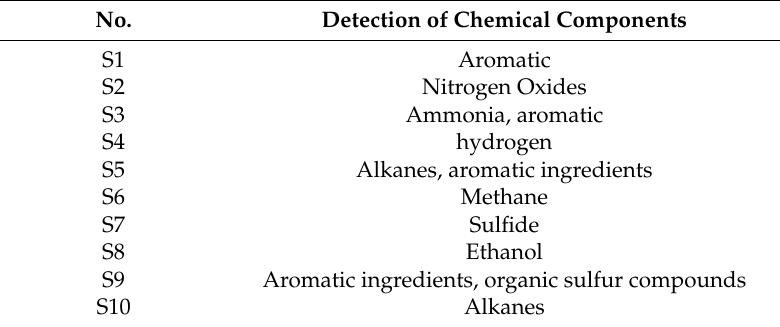
Table 1. The components and main applications of the sensors of the